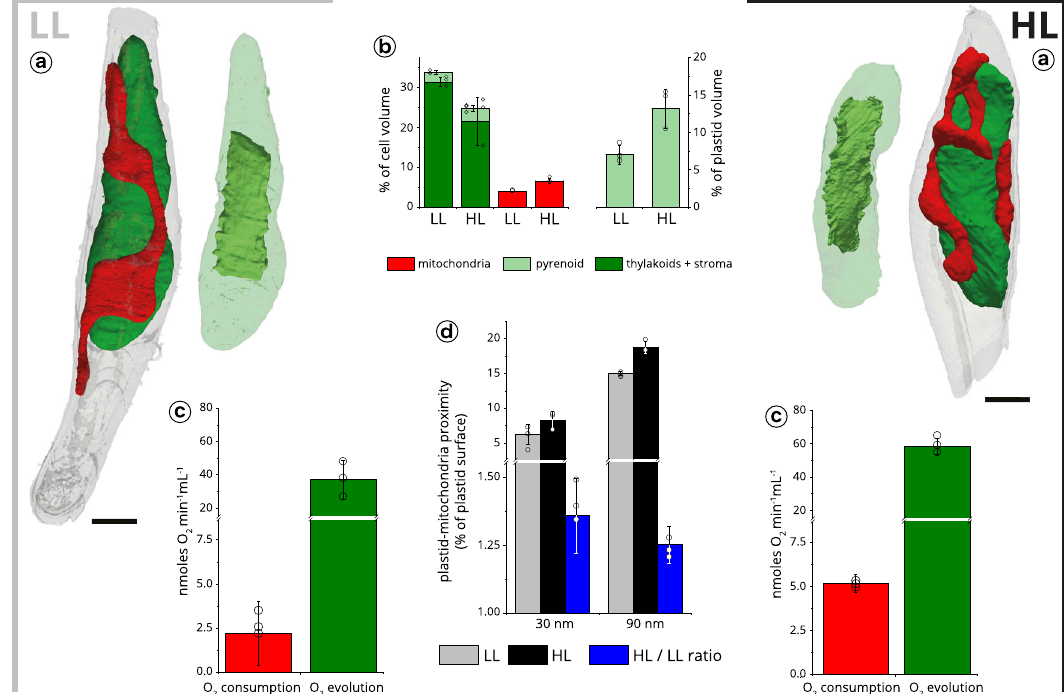
Fig. 6 Structural analysis of light acclimation in Phaeodactylum tricornutum . a Cells were imaged at two different light regimes: LL (40 µ mol photons m − 2 s − 1 , left) and HL (350 µ mol photons m − 2 s − 1 , right). Scale bar: 1 µ m. b Volume occupancy by the plastids (dark green), mitochondria (red) and pyrenoid (light green) in the two conditions. Data refer to three cells ± s.d. for each growth condition. c Respiratory activities (red) and photosynthetic capacities (green) are indicated for LL (left) and HL (right) cells. Data refer to three biological samples ± s.d. for each growth condition. d Plastid- mitochondria proximity surface points in LL and HL cells, measured at ≤ 30 nm (grey) and ≤ 90 nm (black). At both distances, proximity areas points are increased by around 25% (blue) upon HL transition. Data refer to three cells ± s.d. for each growth